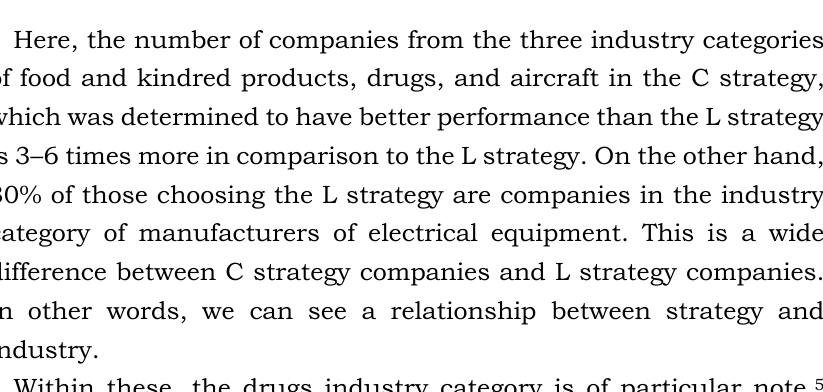
Note: The calculation method is “(the number of C strategy samples occurring in each industry) × (the total number of L strategy samples / the total number of C strategy